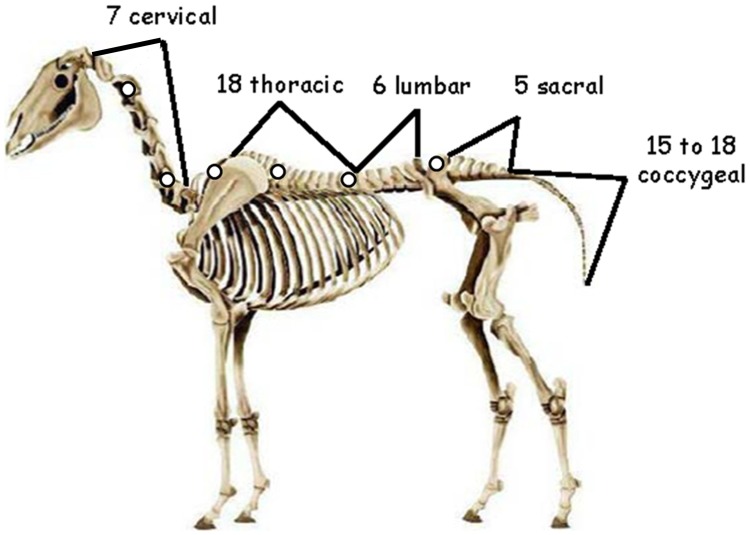
Representation of a horse skeleton with the locations of electrodes for sEMG measurements.The electrodes were placed at the level of the white spots of the figure.